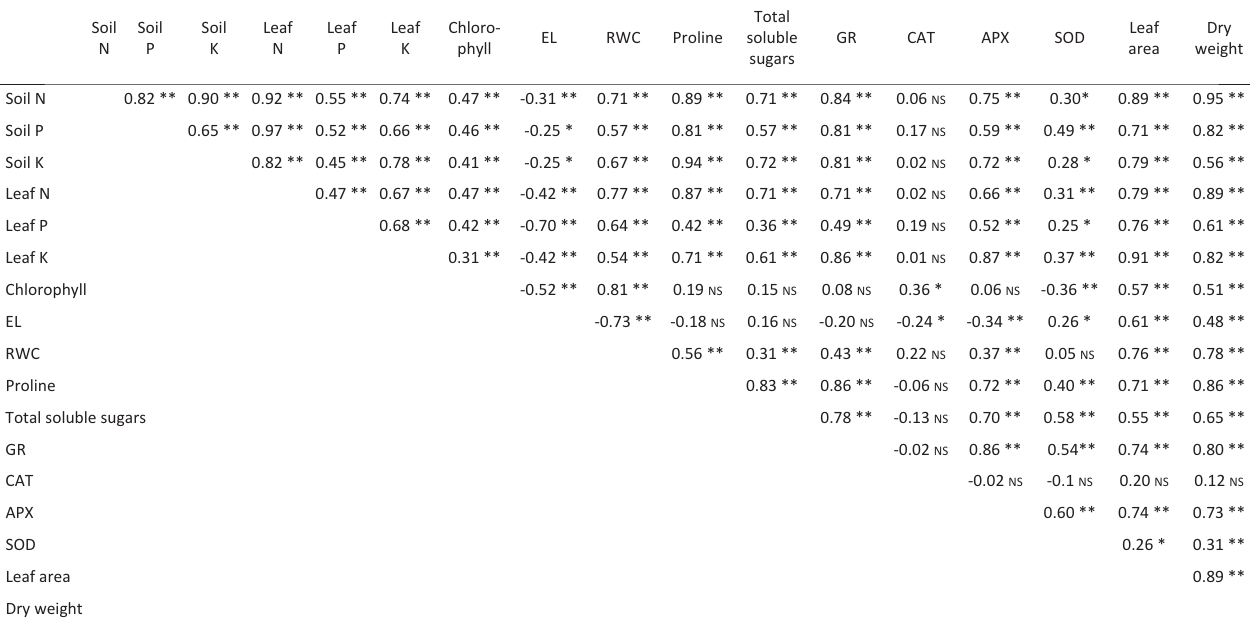
EL= electrolyte leakage, RWC= relative water content, GR= glutathione reductase, CAT= catalase, APX= ascorbate peroxidase, SOD= superoxide dismutase, * P≤0.05; ** P≤0.01; NS = not